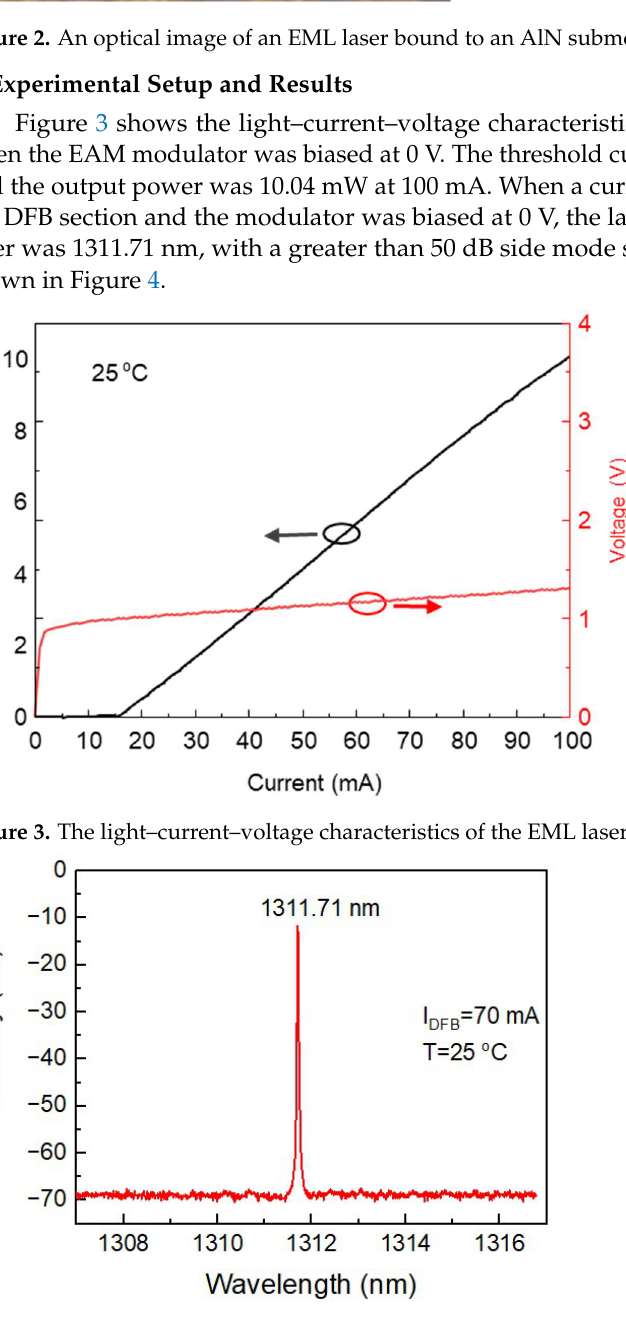
Figure 4. Typical optical spectrum of the DFB section of the EML laser at 70 mA.